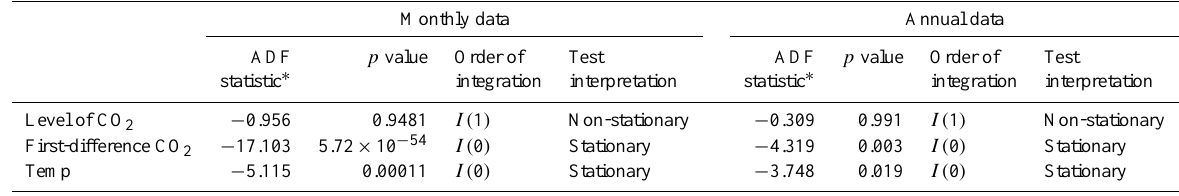
Table 3. Augmented Dickey–Fuller (ADF) tests for stationarity of unit roots in both monthly and annual data 1969 to 2012 for level of atmospheric CO 2 , first-difference CO 2 and global surface